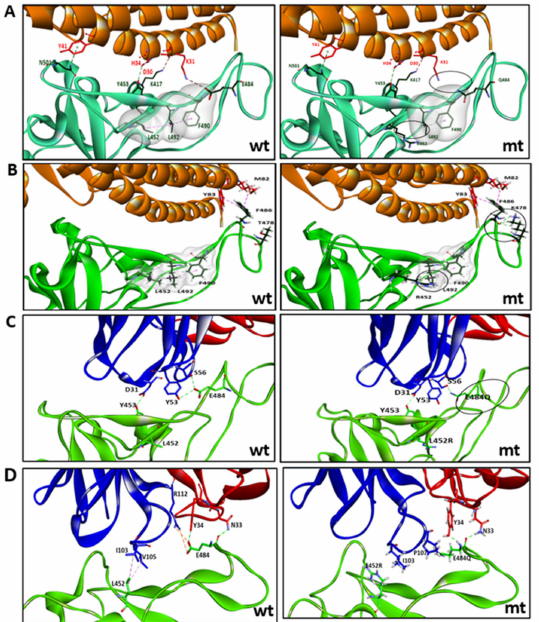
Figure 5. ( A ) Key interactions between ACE2–RBD involving mutations L452R and E484Q in the RBD, as in lineages B.1.617.1 and B.1.617.3. ( B ) Key interactions between ACE2–RBD involving mutations L452R and T478K in the RBD, as in lineage B.1.617.2. ( C ) Interactions between RBD–mAb REGN10933. ( D ) Interactions between RBD–mAb P2B-2F6. wt, corresponds to wildtype strain and mt, mutant strain. In ( A ) and ( B ) are the intra-molecular contacts in a hydrophobic patch of the RBD region (surface displayed in gray). In ( C ) and ( D ), blue represents heavy chain and red represents light